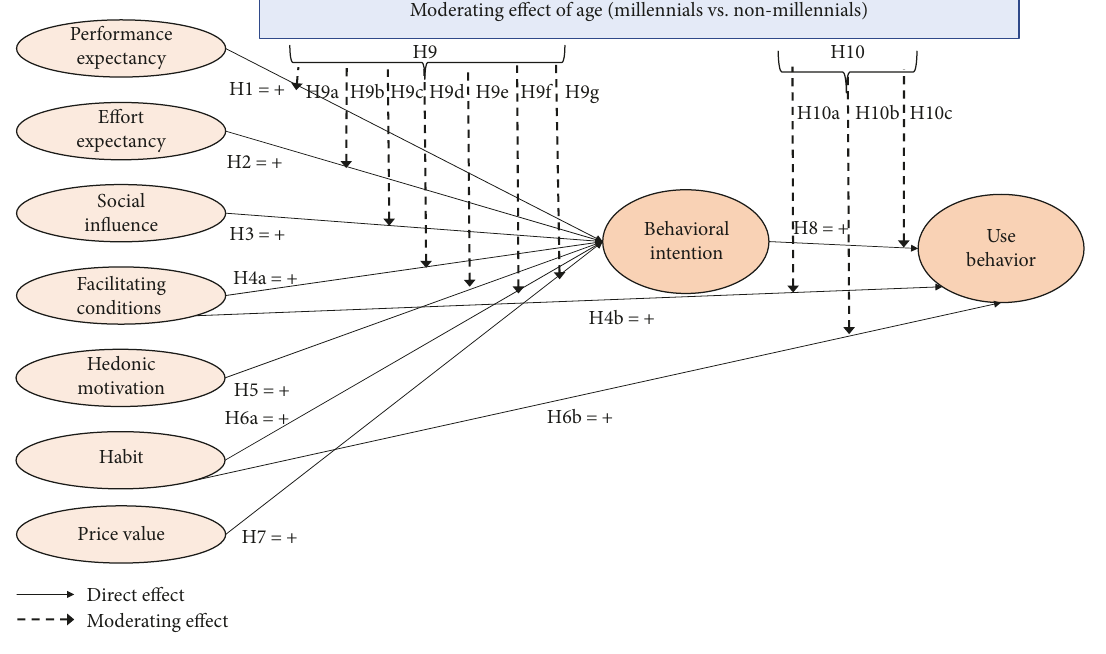
Figure 1: Research